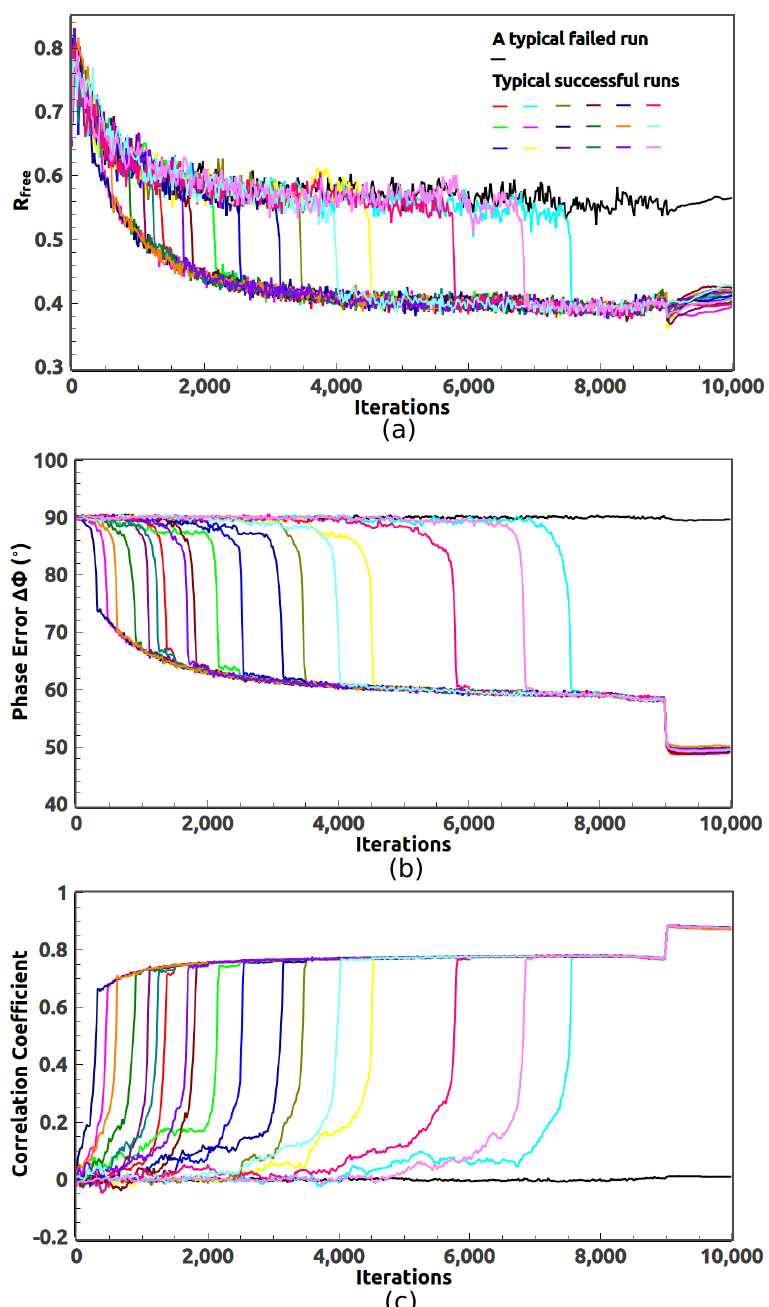
Figure 5. Direct phasing of 4NF2 with NCS averaging. The evolution of error metrics starting from random phases: ( a ) free R-value, ( b ) mean phase error, and ( c ) correlation